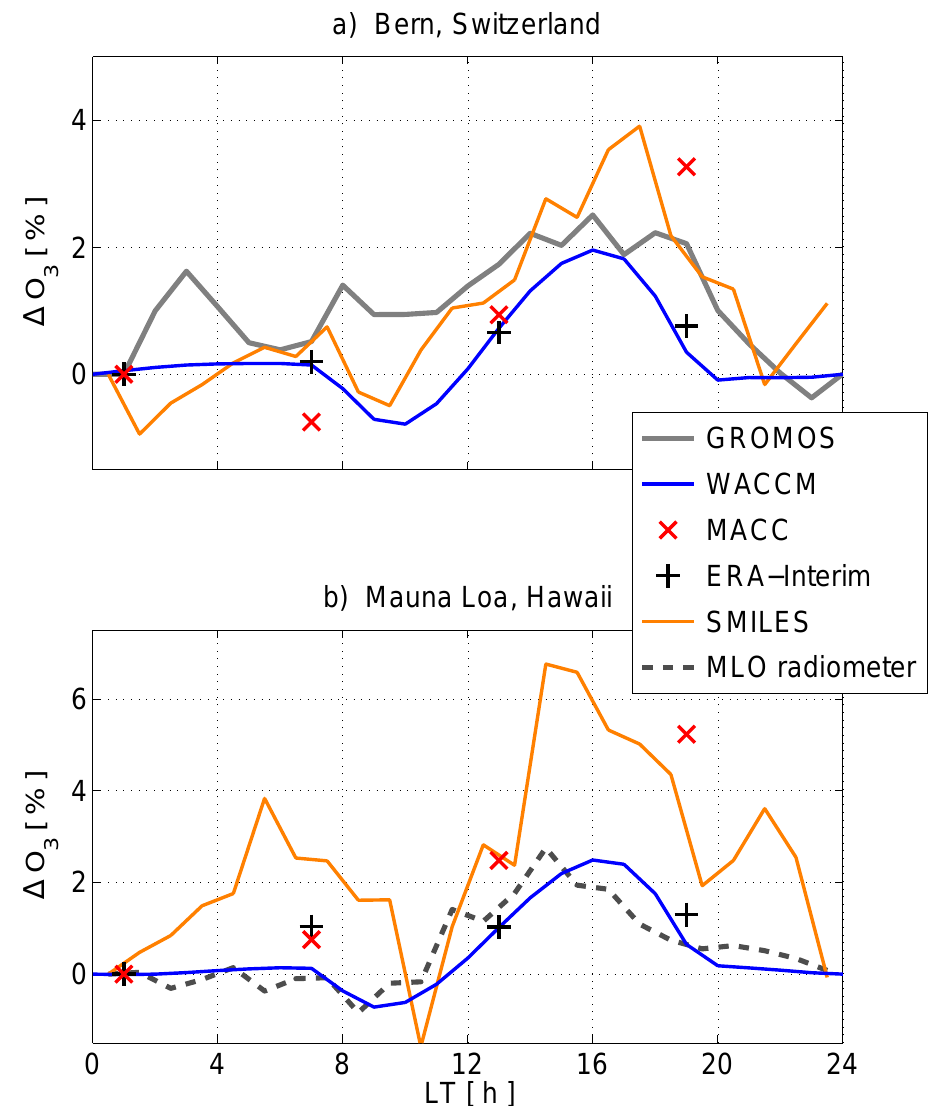
Figure 1. Relative diurnal variation in ozone from WACCM for March 2000, MACC reanalysis and ERA-Interim for March 2012 at 5 hPa over ( a ) Bern, Switzerland (46.9 ◦ N, 7.4 ◦ E) and ( b ) Mauna Loa, Hawaii (19.5 ◦ N, 204.5 ◦ E). The figures show the relative diurnal variation over local time according to Equation (1). The SMILES curves (orange) are for a related period (1 March–21 April 2010) and averaged over belts from 20–50 ◦ N for Bern and 20 ◦ S–20 ◦ N for